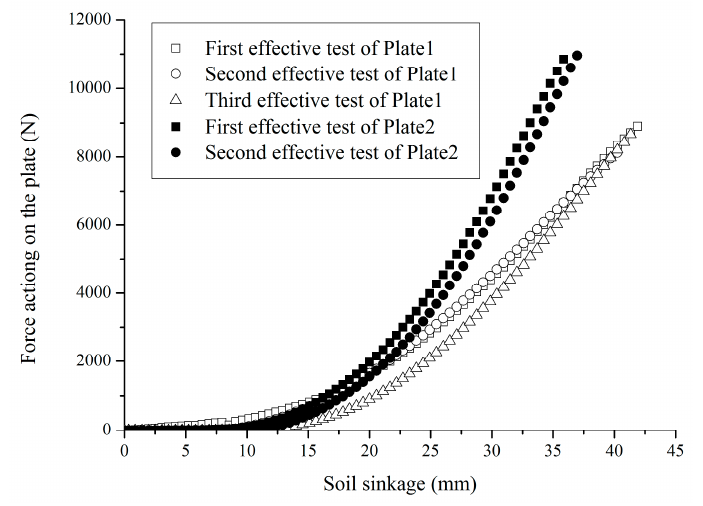
Figure 7. Pressure-sinkage curves of soil.